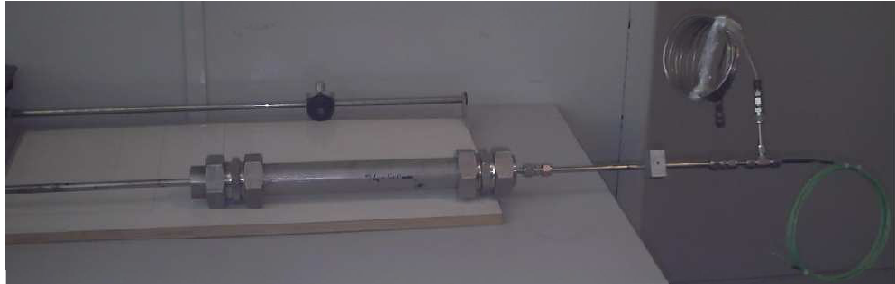
Fig. 1. Photograph of lime pretreatment reactor